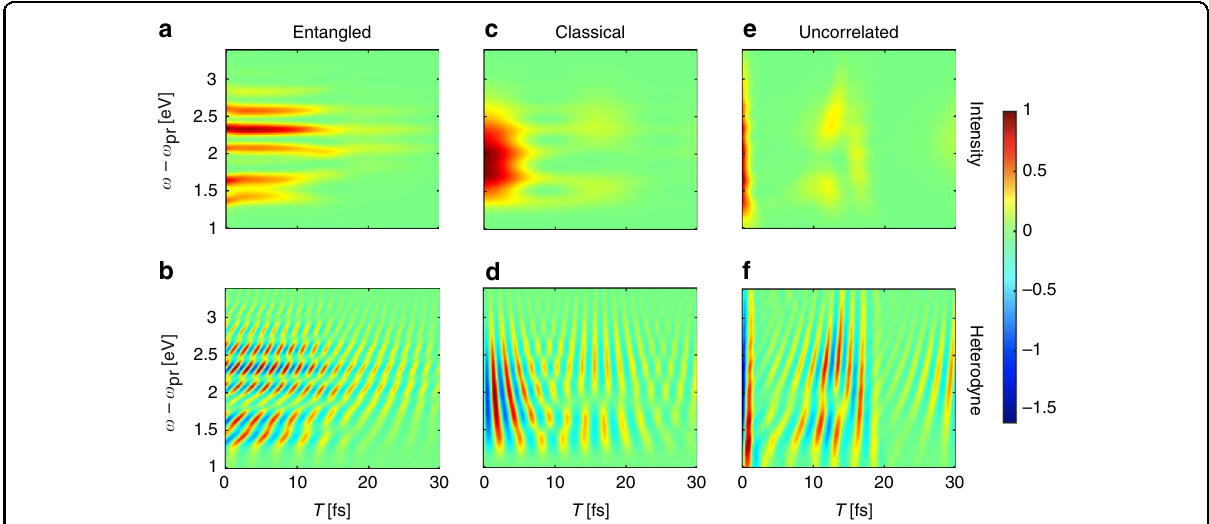
Fig. 2 (First column) ( a ) Intensity-correlated QFRS for time-evolving electronic coherence versus the delay T between entangled photons and resonant pump pulse; b Same as a but for heterodyne detection. c , d Same as a , b but using classical pulse as probe having bandwidth σ 0 = 0.82eV. e , f Same as a , b but using uncorrelated separable state of photons with the bandwidth σ 0 = 0.82eV ( σ (cid:2) 1 high-frequency vibrations and other low-energy degrees of freedom; F 1 = 2.2, F 2 = 1.3, D (cid:2) 1 = 2